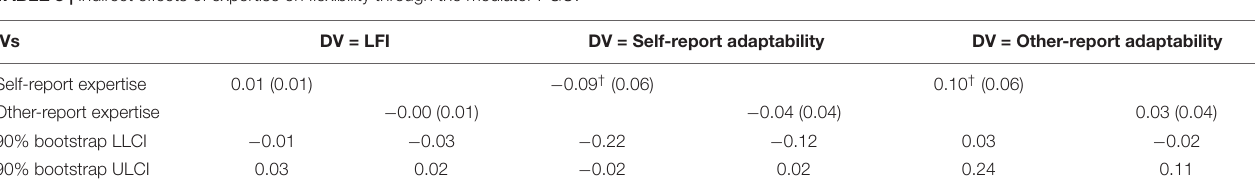
TABLE 3 | Indirect effects of expertise on flexibility through the mediator